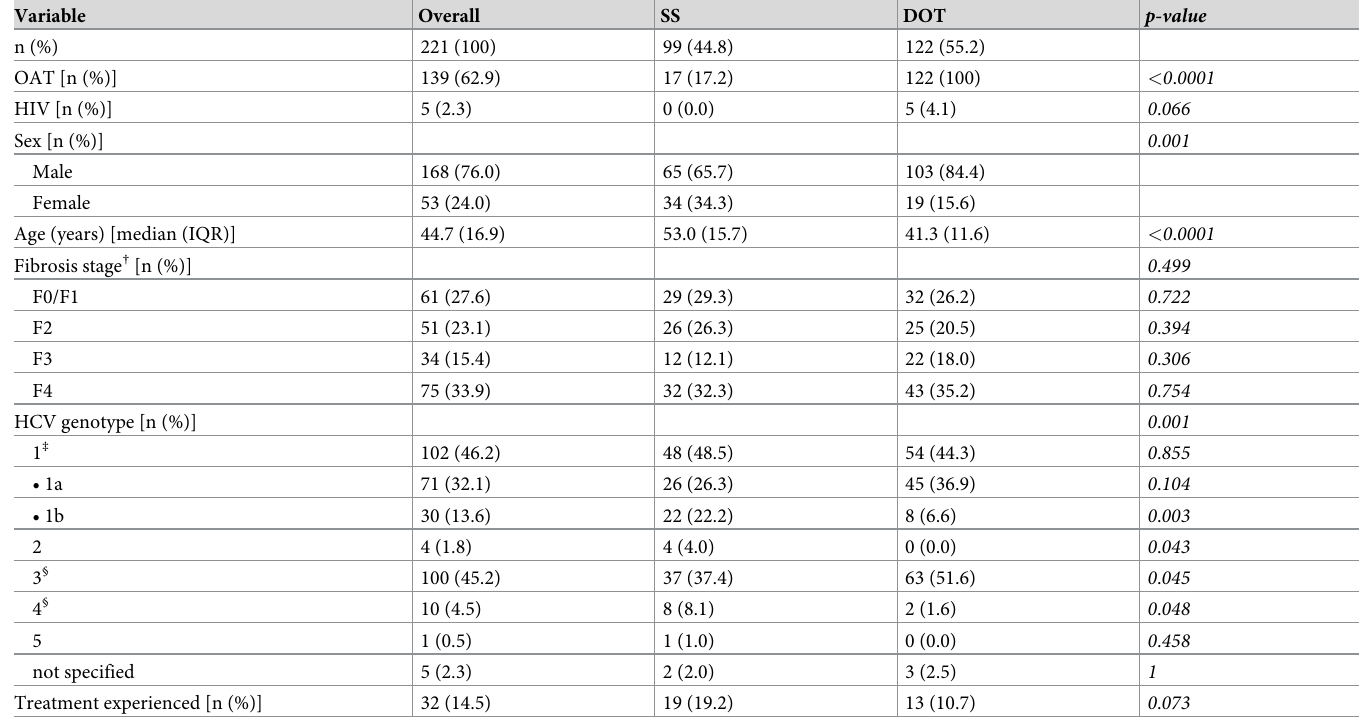
Table 1. Baseline